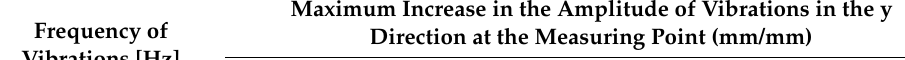
Table 6. Maximum multiples of vibration amplitude values in the y